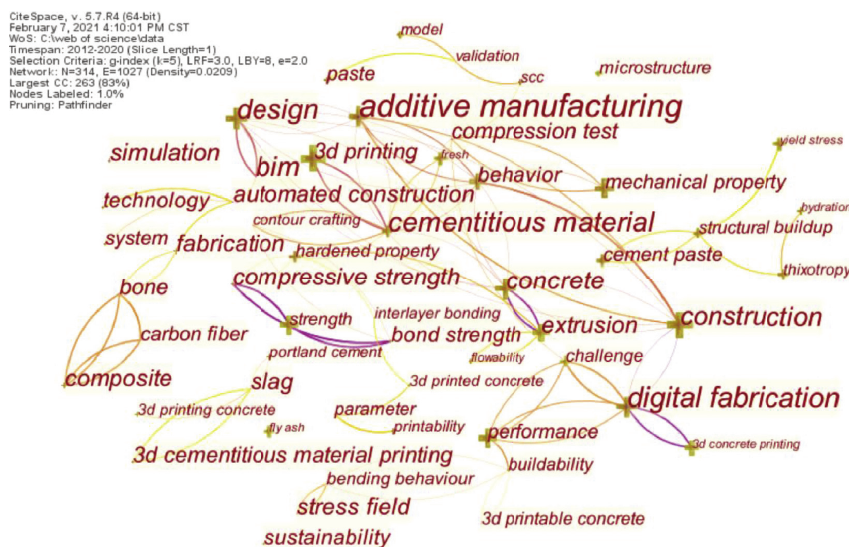
Figure 4: Visualization of keywords based on cooccurrence network.